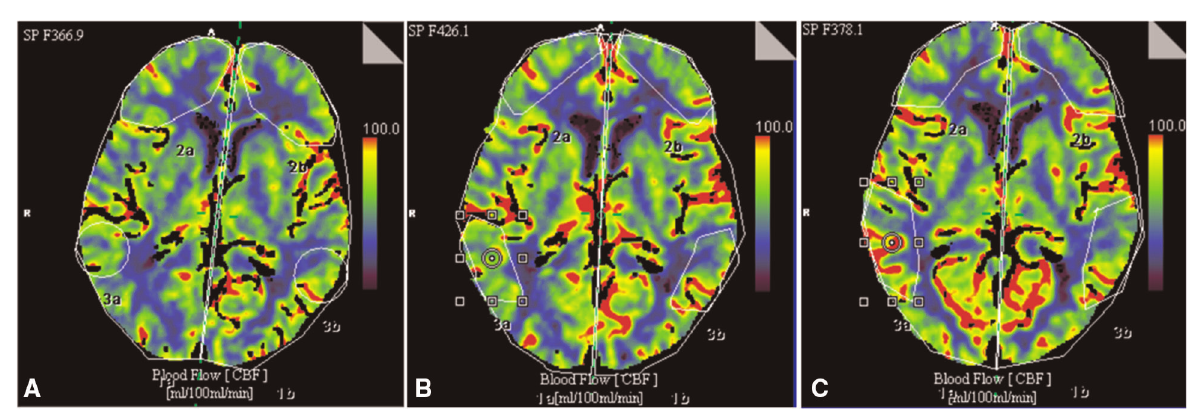
FIGURE 2 An example of changes in CBF in a 78-year-old patient with chronic cerebral ischemia before implantation of the stimulation system ( A ), on day 5 ( B ) and 1 year ( C ) after implantation of the spinal cord system at the level of Th9 –